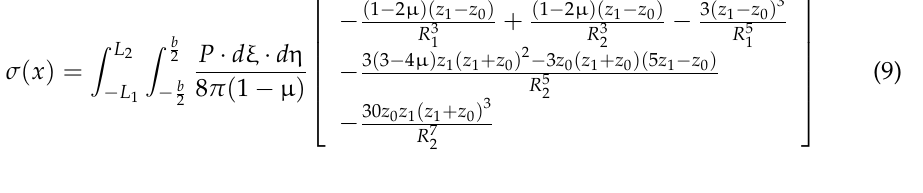
Figure 5. Calculation model diagrams: ( a ) Front view and ( b ) Bird’s-eye view. After excavation, the upward unloading pressure P is generated on the floor of the excavated area. P is the difference between the weight of excavated soils and the support structure per unit excavation length. In Section 2.2, the authors assume that the stratum is a homogeneous isotropic elastomer. According to the principle of elastic mechanics, when a vertical concentrated force acts inside an elastic semi-infinite space, an arbitrary point in the semi-infinite space will be subjected to a vertical additional stress caused by this concentrated force. The magnitude of the additional stress was answered by Mindlin in 1936 [20]. Therefore, Mindlin’s solution is used in this paper. Without considering the effect of the existing shield tunnels on the additional stress, the vertical unloading stress σ ( x ) at an arbitrary point ( x , 0, z 1 ) on the shield tunnel axis level, which is caused by upward unloading pressure P at an arbitrary point ( ξ , η , z 0 ) on the floor of the excavation area, can be obtained.